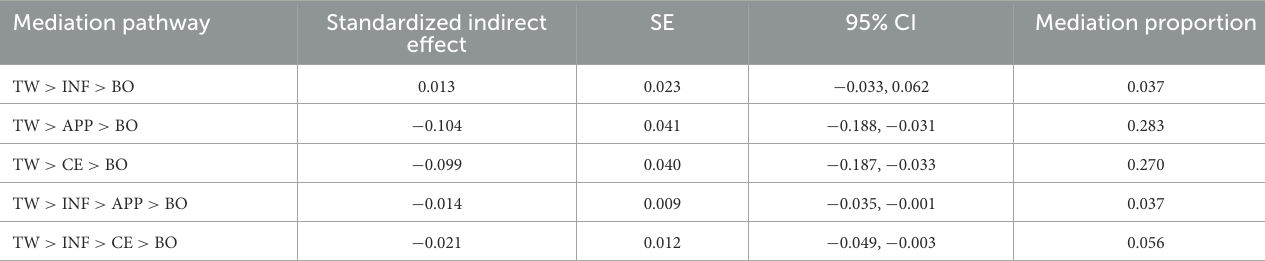
TABLE 3 Indirect effects for the indirect pathways between teamwork (TW) and burnout (BO). Mediation